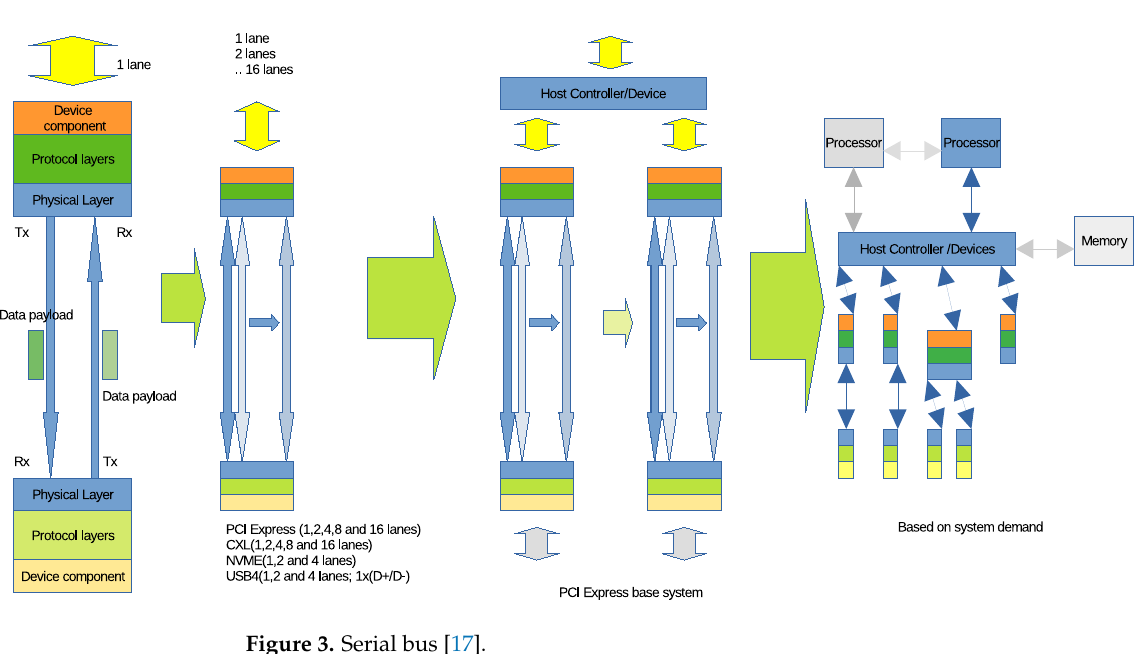
Figure 3. Serial bus [17].